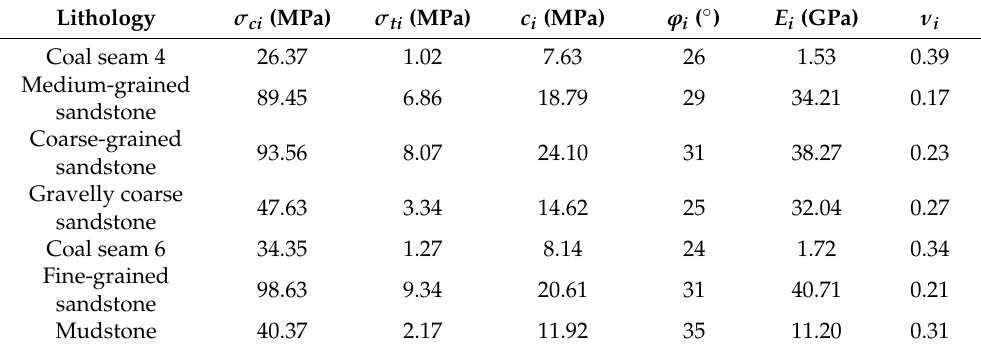
Table 1. Properties of rock mass in panel 26,102.